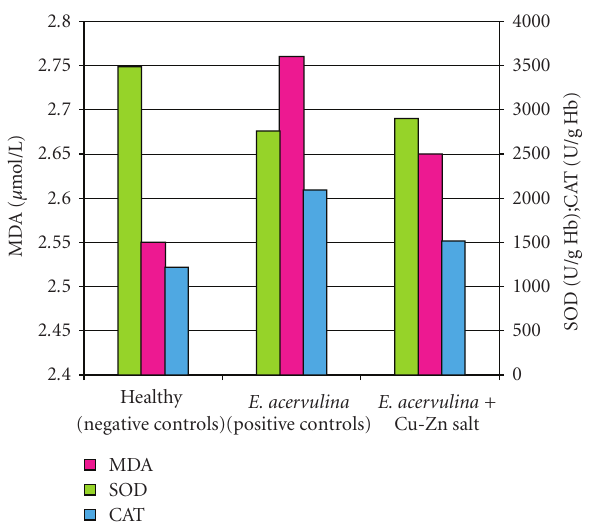
Figure 1: Blood MDA concentrations and erythrocyte SOD and CAT activities in chickens.